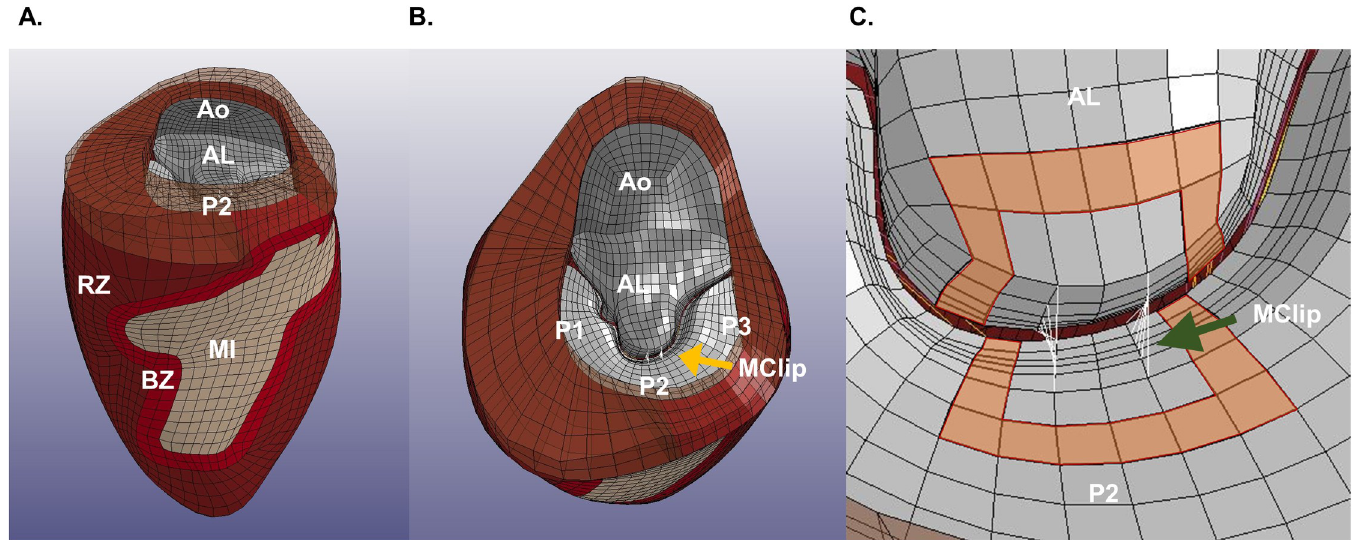
Fig 1. Representative FE mesh of the LV with Mitral Valve and MitraClip modeled as virtual sutures. Views include (A) LV showing postero-lateral MI, (B) en face view of the mitral valve with MitraClip and (C) close up of MitraClip as virtual sutures. The leaflet elements used for stress calculation are marked in orange. BZ–infarct borderzone; RZ–remote myocardium; AL–anterior leaflet; P1,2,3 –posterior leaflet sections; Ao–capped region of aortic outflow and MClp–MitraClip.